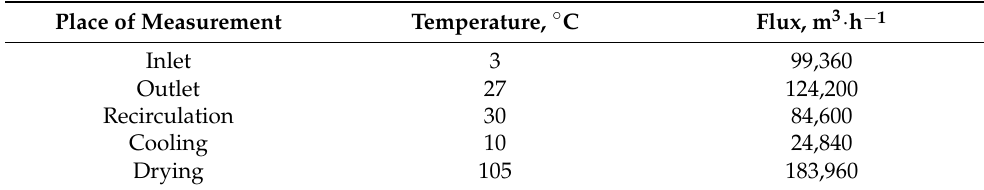
Table 6. Temperatures and streams of drying gas streams of the DT2532